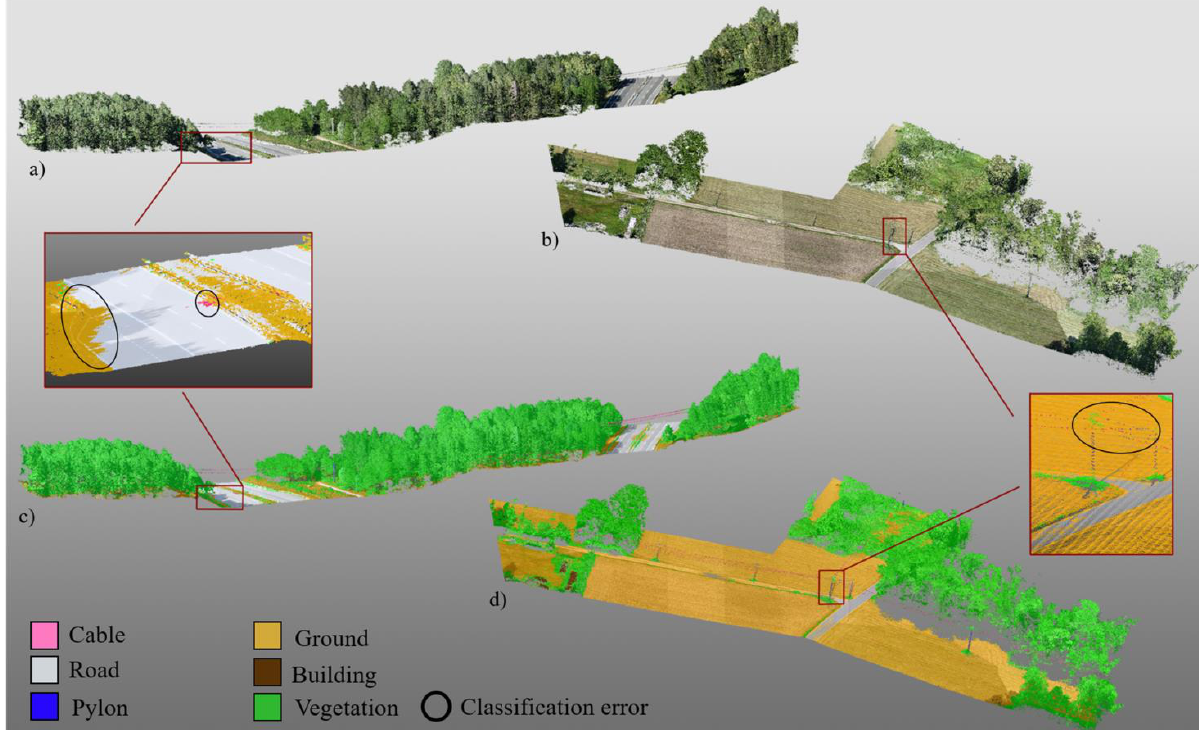
Figure 7. RGB point clouds (a: MT 1, b: MT 2) and corresponding classification results (c: MT 1, d: MT 2). The detailed views show examples where the classification algorithm failed to correctly label the points.